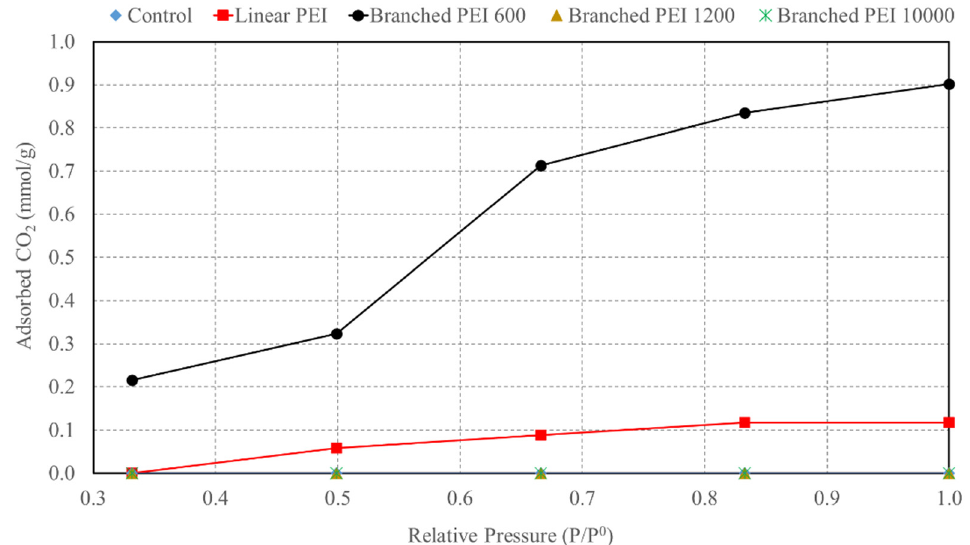
Figure 4. Impact of PEI arrangements and molecular weights on CO 2 sorption behavior of γ -CD MOFs .